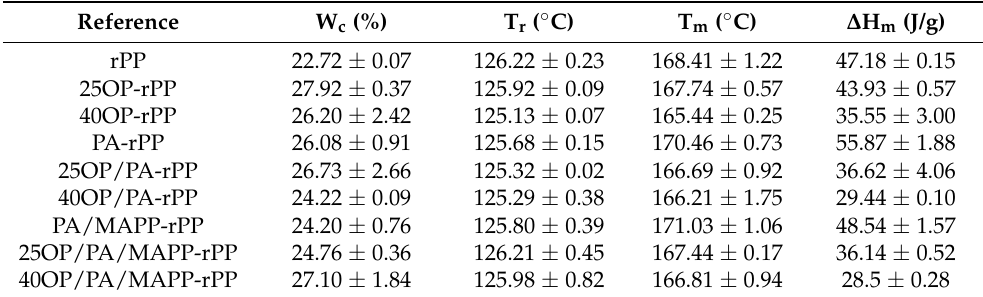
Table 6. Values of the different thermal parameters obtained from the DSC curves of the rPP, PA-rPP, PA/MAPP-rPP and the different composites.